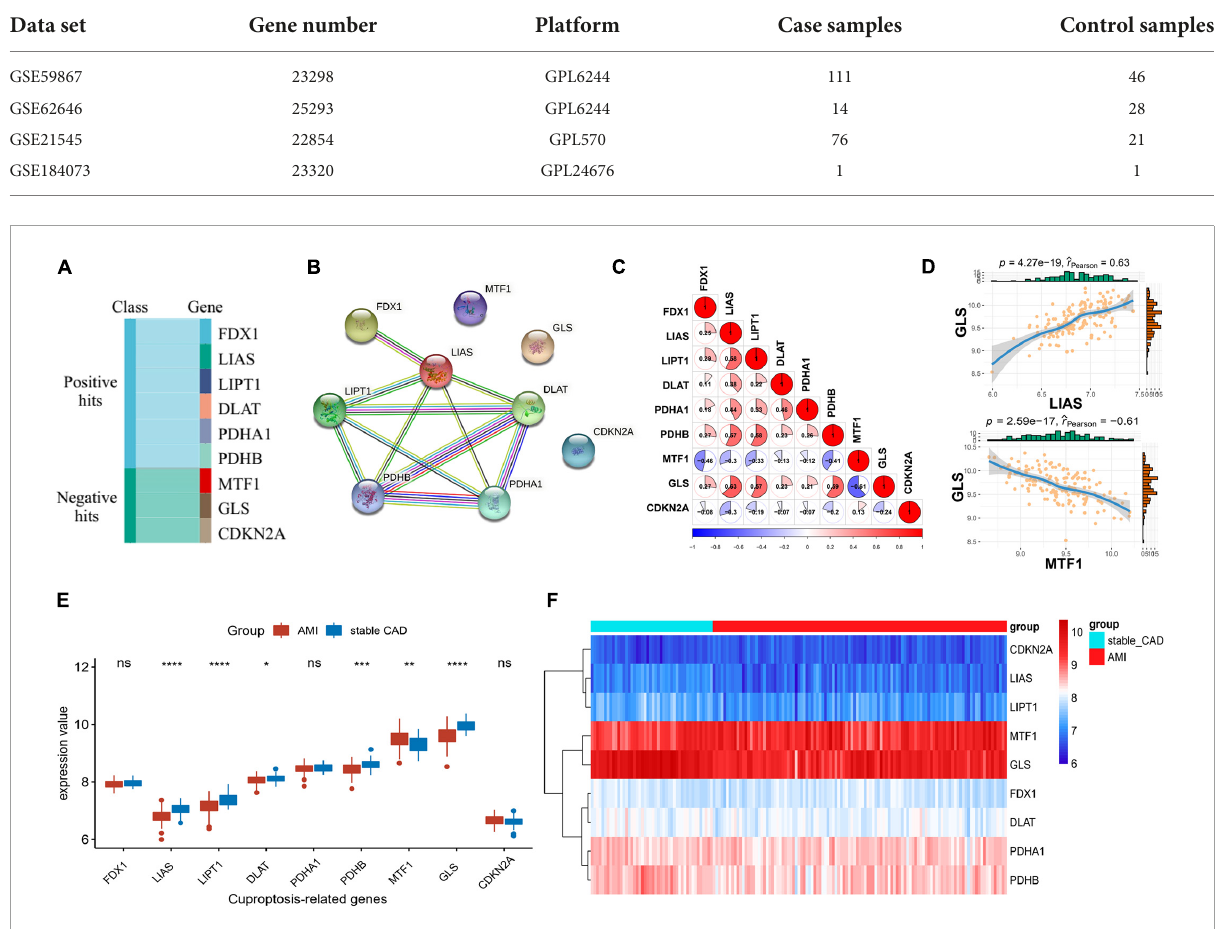
FIGURE1 Differential expression landscape of cuproptosis-related genes (CRGs). (A) Classification of genes associated with CRGs. (B) Protein–protein interaction (PPI) network of CRGs. (C,D) Correlation analysis of CRGs in AMI. (E) The boxplot of CRGs differential expression. (F) The heatmap of CRGs (stable_CAD, stable coronary heart disease; AMI, acute myocardial infarction). * P < 0.05, ** P < 0.01, *** P < 0.001, **** P <